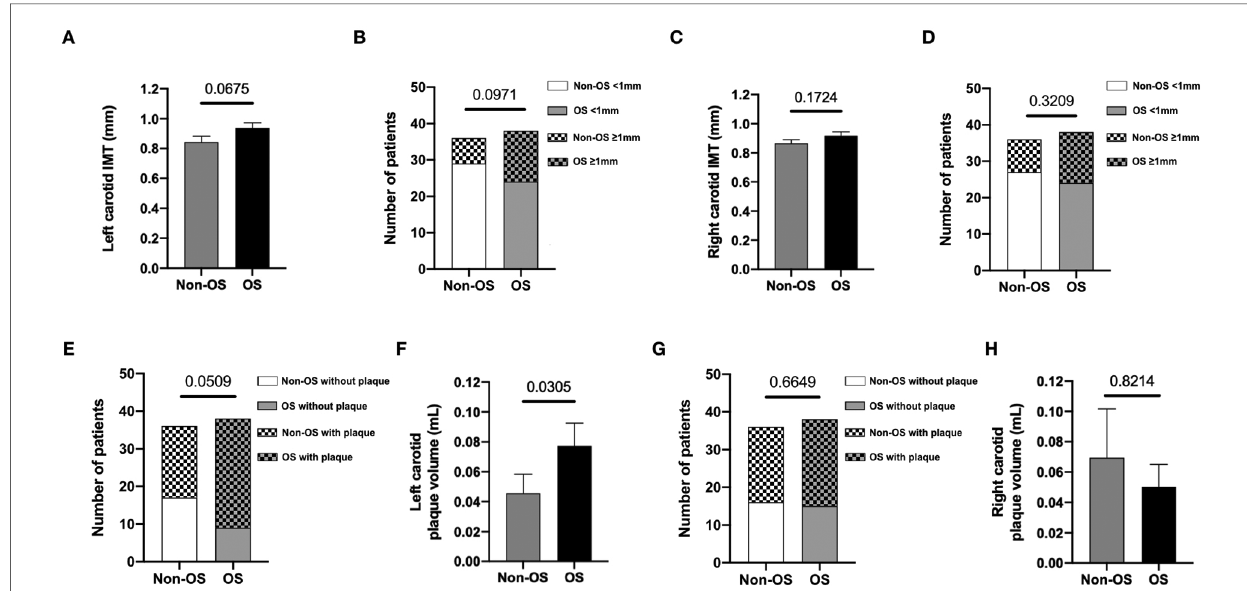
FIGURE 2 Increased prevalence of left carotid atherosclerosis in COPD patients with overlap syndrome. Number of COPD patients, with and without OS, with left and right carotid IMT measurements (panels A and C, respectively) and differences between the study groups regarding mean IMT of left and right carotids (panels B and D, respectively). Number of COPD patients, with and without OS, with left and right carotid plaque measurements (panels E and G , respectively) and differences between the study groups regarding mean volume of left and right carotid plaques (panels F and H, respectively). COPD, chronic obstructive pulmonary disease. Non-OS, non-overlap syndrome, n =36. OS, overlap syndrome, n